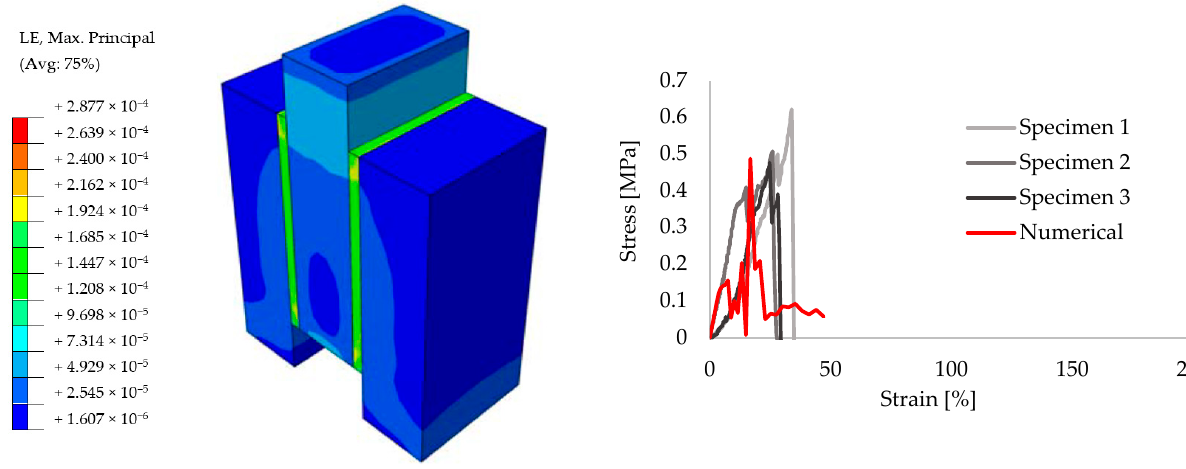
Figure 13. Tension results for the small size specimens with PolyUrethane PM: true strain diagram ( left ) and comparison of